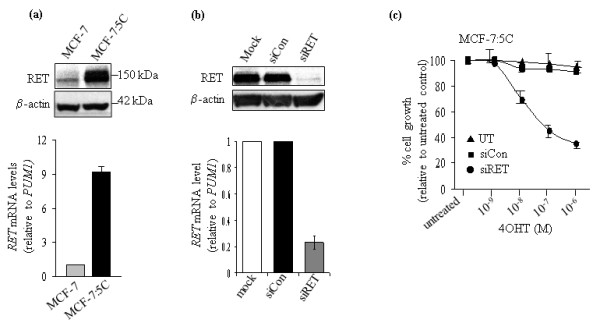
Knockdown of RET mRNA expression sensitizes endocrine-resistant MCF-7:5C breast cancer cells to 4-hydroxytamoxifen. (a) Rearranged during transfection (RET) protein and mRNA levels in wild-type MCF-7 cells and endocrine-resistant MCF-7:5C cells as determined by western blot analysis and quantitative real-time PCR, respectively. (b) MCF-7:5C cells were transfected with either a RET-targeted siRNA or a nontarget control siRNA for 48 hours and RET protein and mRNA expression levels were determined by western blotting and real-time PCR. (c) Effect of RET suppression on the proliferation of MCF-7:5C cells. Cells were transfected with a RET-targeted or a nontargeting control siRNA, and after 24 hours cells were seeded into 12-well plates and exposed continuously to the indicated concentrations of 4-hydroxytamoxifen (4OHT) or vehicle for an additional 72 hours. Cell proliferation was determined by cell counting using a hemacytometer. Data shown are representative of three independent experiments. UT, untreated.